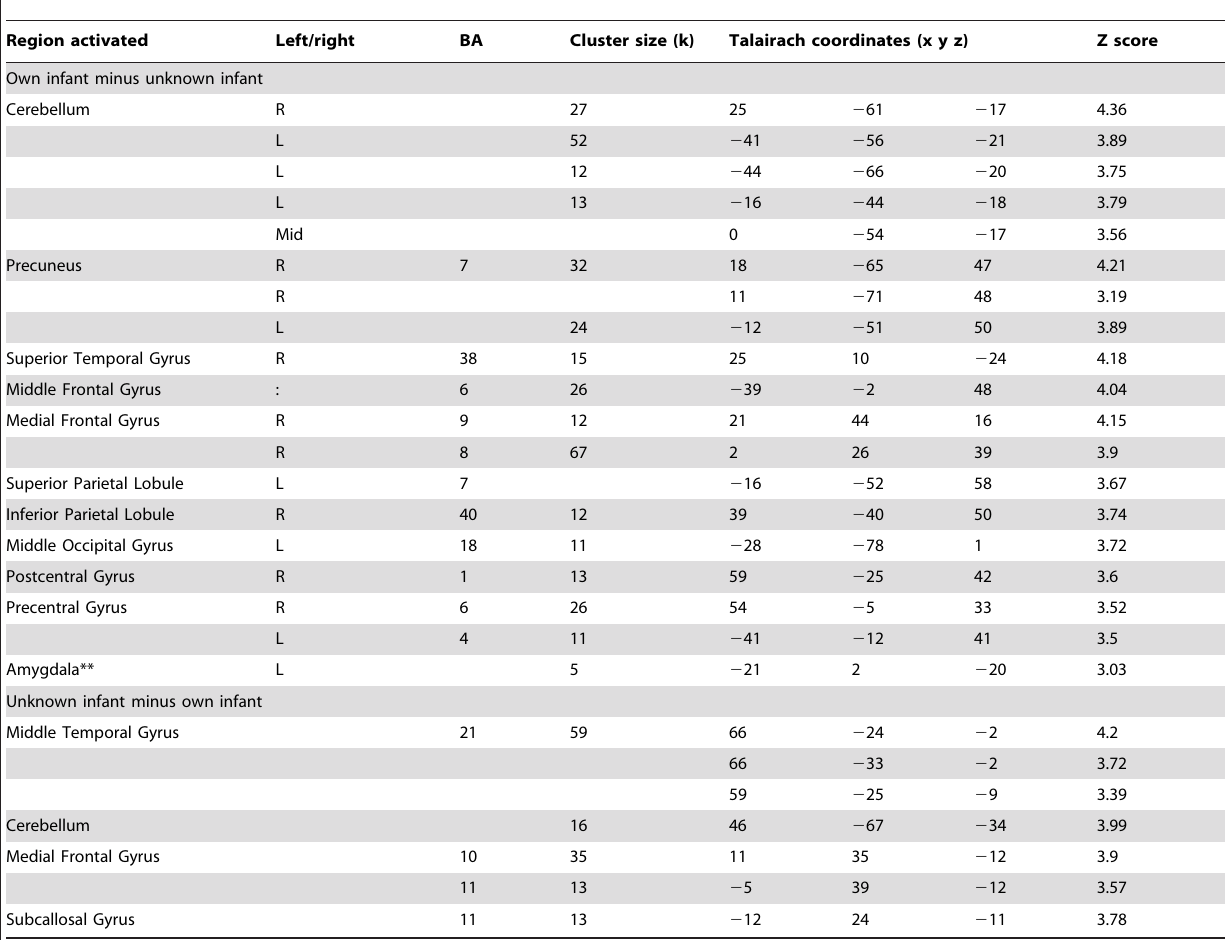
Table 3. Areas of significant activation in own . unknown infant contrast.*